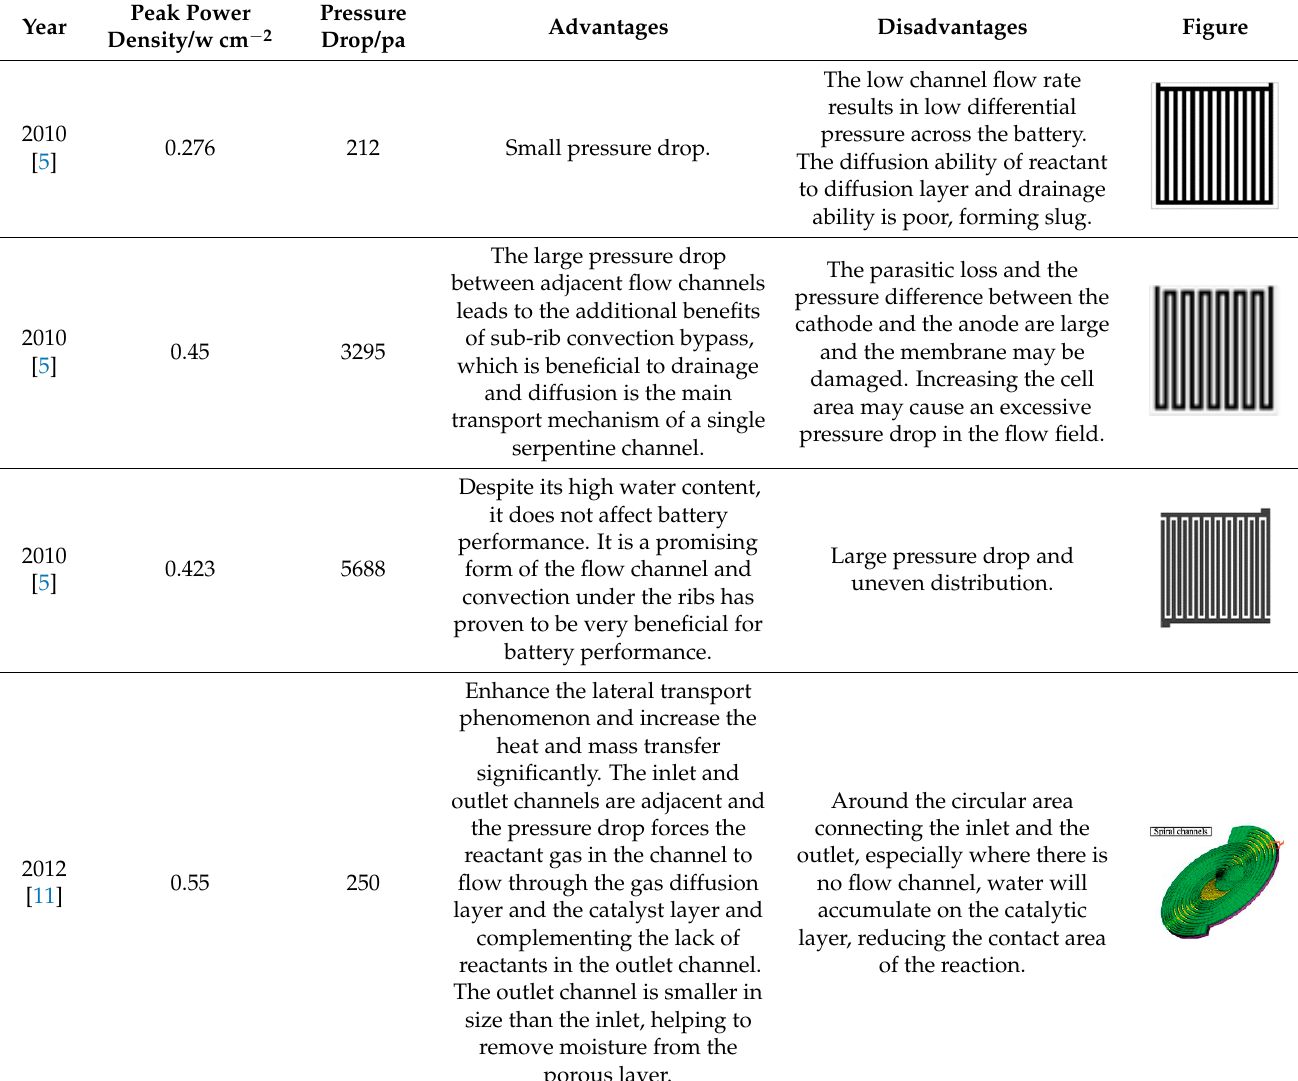
Table 1. Summary of flow channel design for PEM fuel cells.